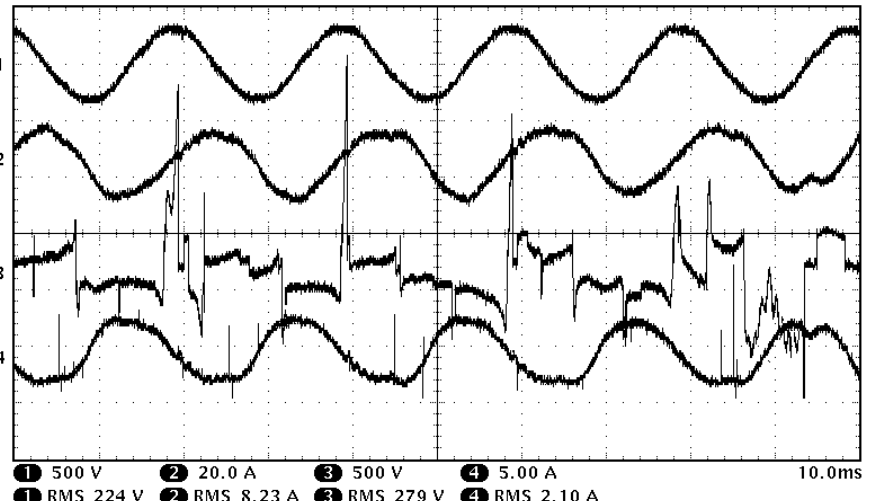
Figure 9. Current and voltage waveforms of the ITPS power supply, 1 — input voltage, 2 — input current, 3 — output voltage, 4 — output current, plasma gas: argon, flow: 2.8 m 3 /h.